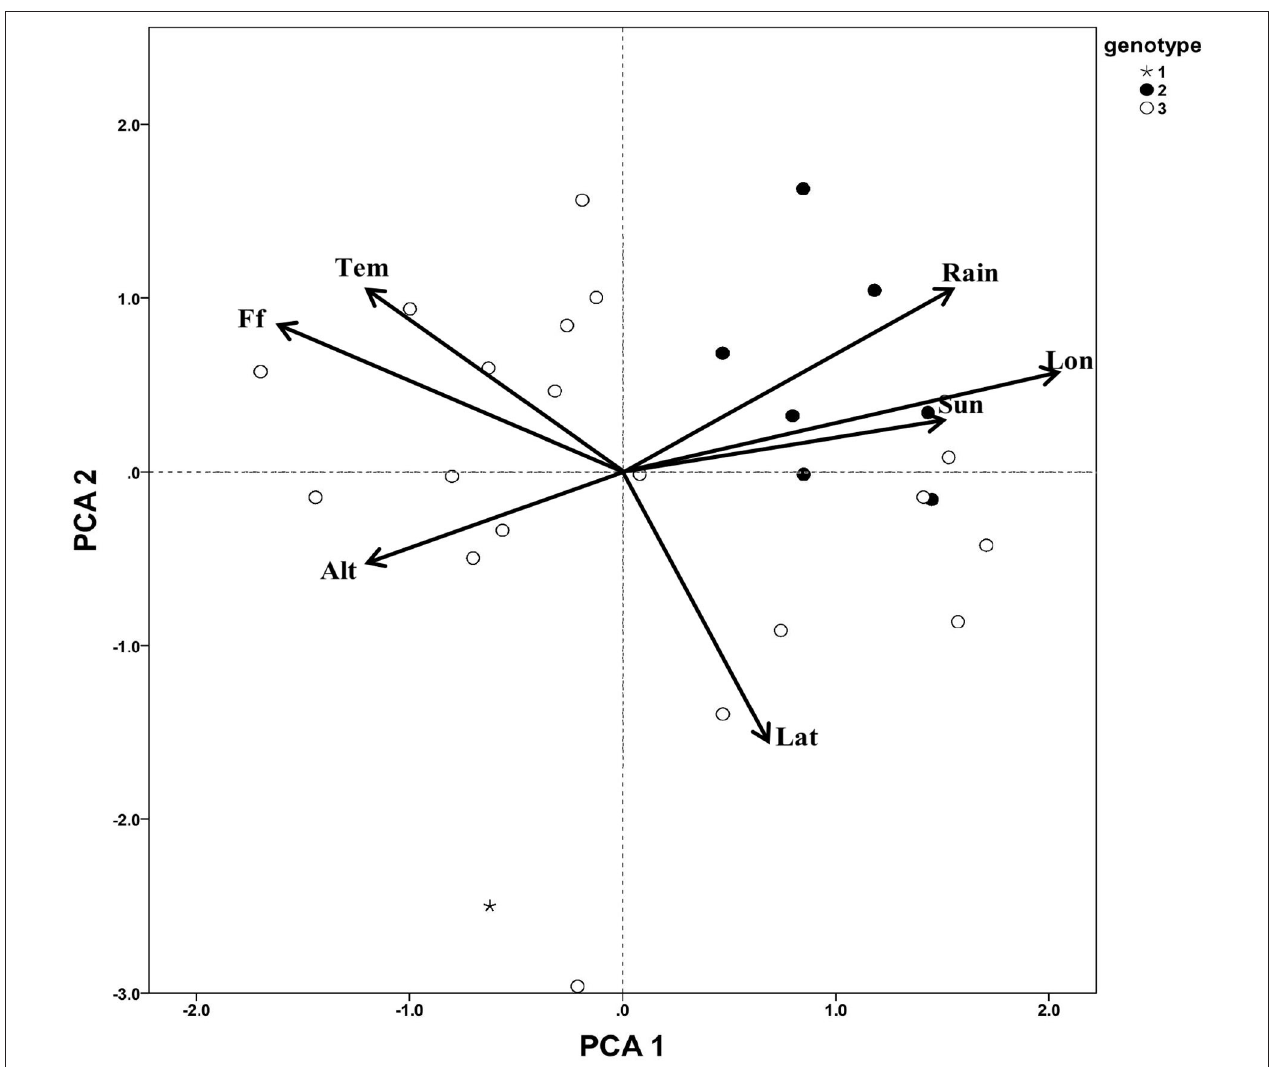
FIGURE 3 | Principal component analysis of distributing environment factors of C. paliurus germplasm. Tem, annual mean temperature; Rain, annual precipitation; Lat, latitude; Lon, Longitude; Sun, annual sunlight hour; Alt, altitude; Ff, frost-free days.